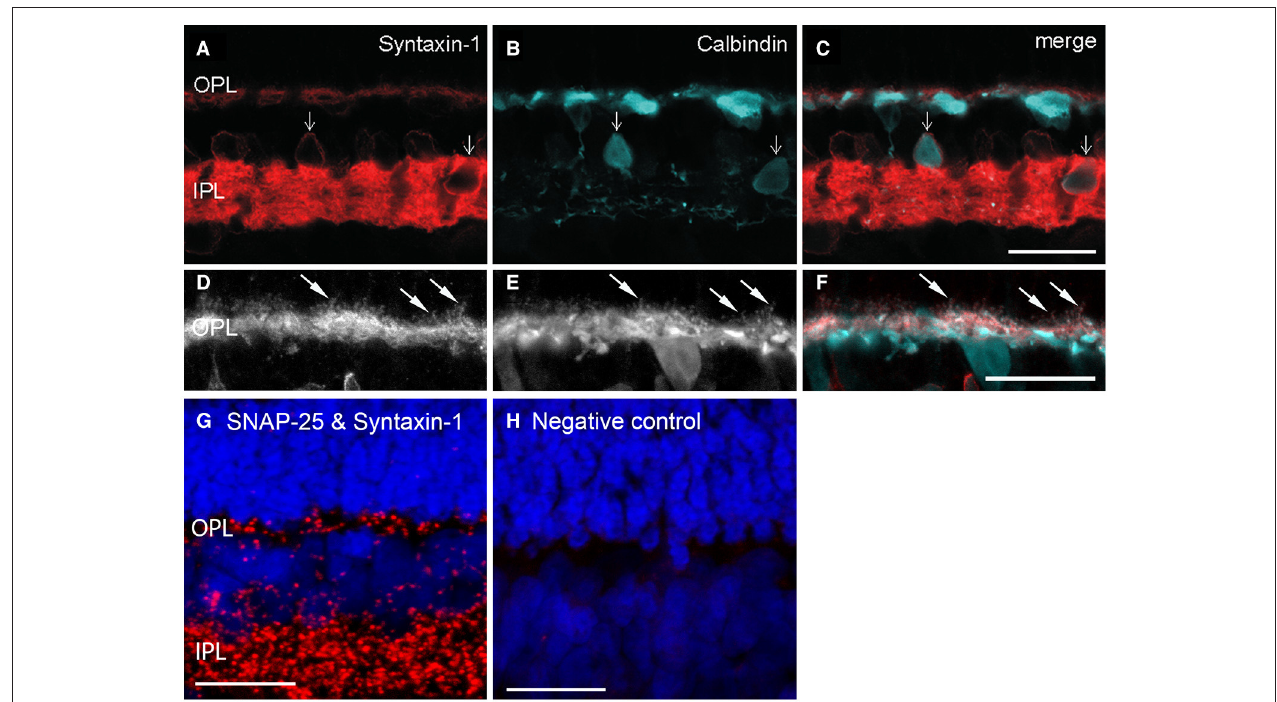
FIGURE 7 | Cellular localization of syntaxin-1a to horizontal cells and their processes and endings in photoreceptor synapses. (A) Syntaxin-1a (red) immunolabeling co-localized with that of (B) calbindin (blue) in horizontal cell bodies and processes in the OPL (C) , as well as some amacrine cell bodies (arrows) in the INL in rabbit retina. In addition to horizontal cells, calbindin immunoreactivity was present in a subtype of bipolar cell and amacrine cells in rabbit retina. OPL, outer plexiform layer; IPL, inner plexiform layer. (D–F) Higher magnification views of immunolabeling for syntaxin-1a (D) , calbindin (E) , and merged image (F) in the OPL of rabbit retina. Arrows point to horizontal cell endings. (A–C) Single optical section; (D–F) maximum intensity projection, z = 2.88 µ m. (Modified from Hirano et al., 2005). (G,H) In situ proximity ligation assay (PLA) revealed protein interactions between the plasma membrane SNARE proteins SNAP-25 and syntaxin-1a in both plexiform layers. (G) In situ PLA marks close (within 40nm) protein interactions and identifies these interactions as distinct puncta that are localized to the OPL and more densely in the IPL of guinea pig retina. (H) Negative controls in which one of the antibodies was omitted resulted in no puncta. (G,H) Confocal images were scanned at 0.5 µ m intervals, and maximum intensity projection of 9 optical images, z = 4.0 µ m. Scale bar, 20 µ m ( A–C in C , D–F in F , G,H ). (Modified from Brecha et al.,